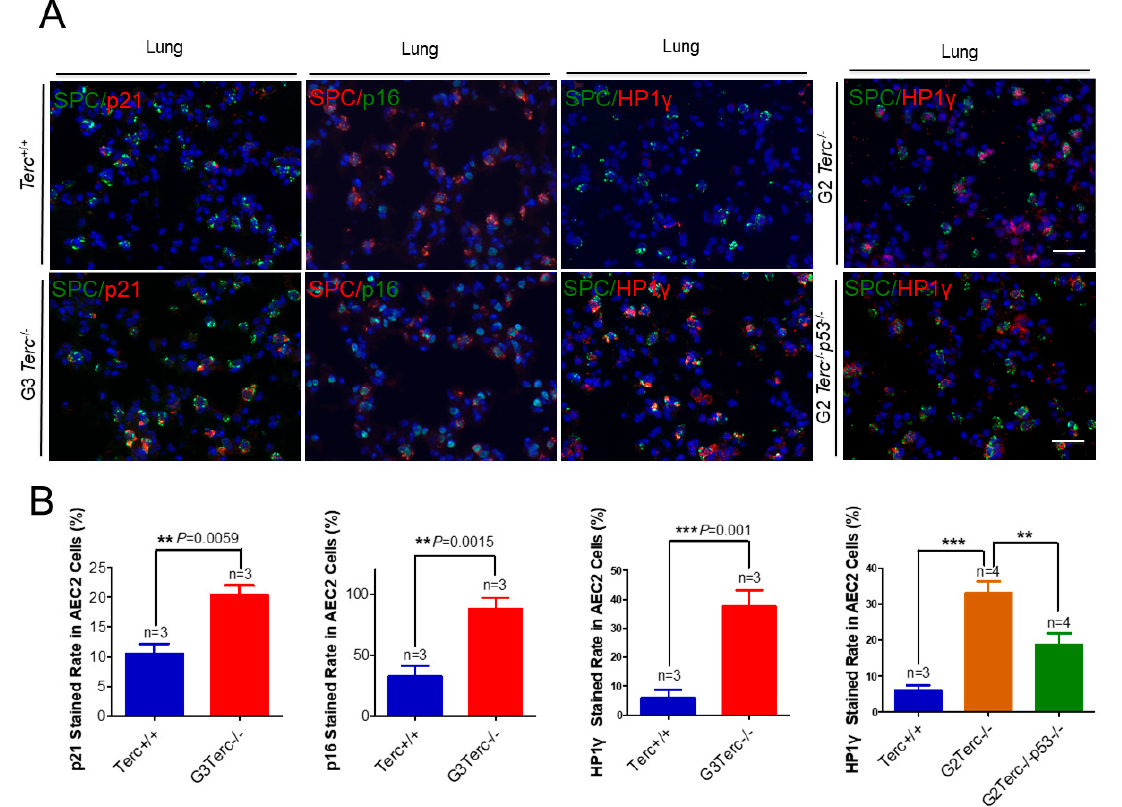
Figure 3. Marked increases in p21, p16, and SAHF-associated Hp1 γ staining rates in AEC2 cells from late-generation Terc − / − lungs, and p53 deletion significantly reversed increased Hp1 γ expression. ( A ) Representative double immunofluorescence staining of Terc +/+ , G3 Terc − / − , G2 Terc − / − , and G2 Terc − / − p53 − / − mouse lungs (magnification: 40×) for SPC along with p21, p16, or Hp1 γ . Scale bar = 30 μ m. ( B ) Quantification of p21-, p16-, and Hp1 γ -stained AEC2 cells by cell counting (as in A). Data are mean ± SE values based on the indicated number of lungs. Statistical significance is indicated by ** p < 0.01, *** p < 0.001.